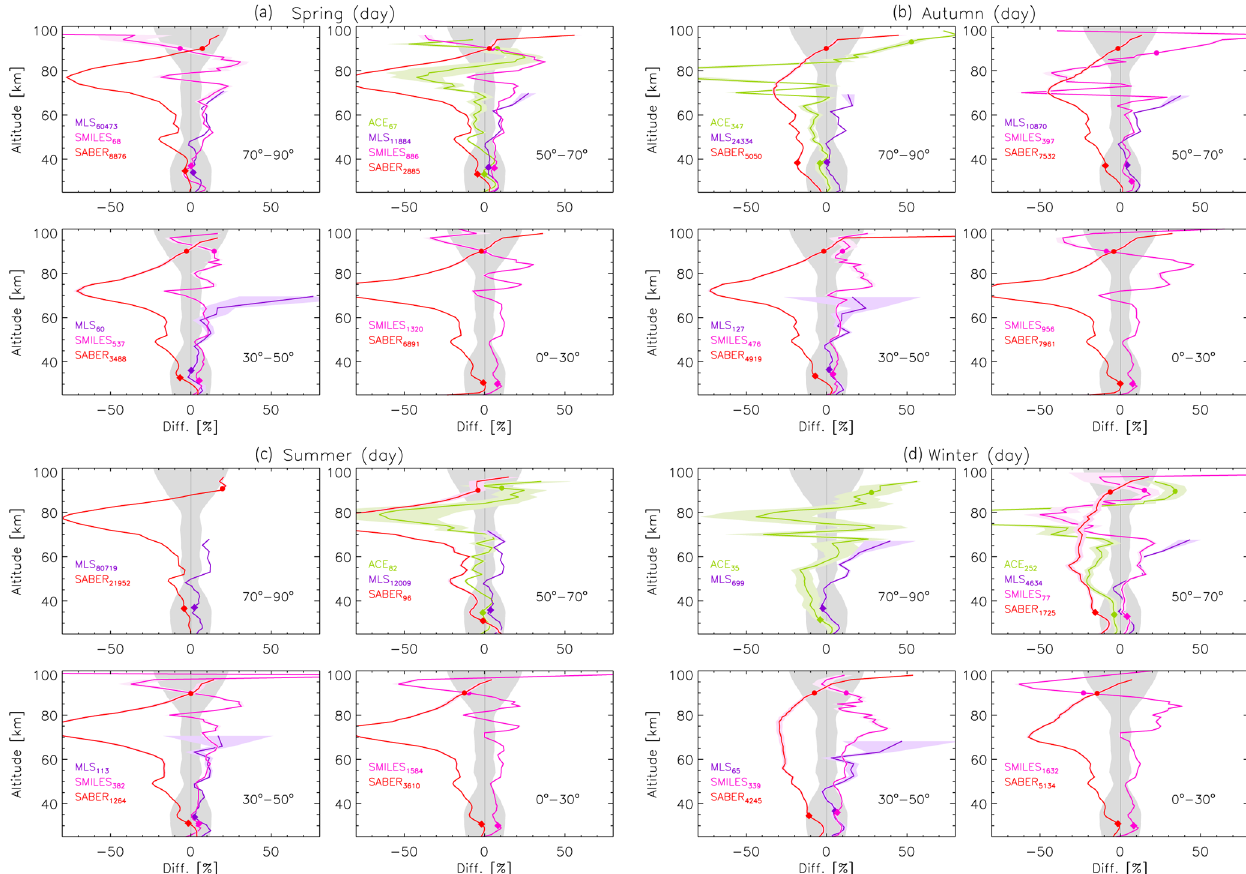
Figure 7. Mean of the daytime O 3 VMR differences (MIPAS–instrument) in % of MIPAS between co-located pairs of measurements of MIPAS (MA mode) with ACE-FTS (green), SABER (red), MLS (purple), and SMILES (magenta) for spring (MAM for NH and SON for SH) (a) , autumn (SON for NH and MAM for SH) (b) , summer (JJA for NH and DJF for SH) (c) , and winter (DJF for NH and JJA for SH) (d) . The symbols indicate the mean altitude of the MIPAS O 3 VMR primary (diamonds) and secondary (circles) maxima coincident with the respective instrument. The numbers of coincidences are indicated in the subscripts. The grey shaded area shows the MIPAS systematic errors. The colour-shaded areas (hardly noticeable in many cases) are the standard errors of the mean of the